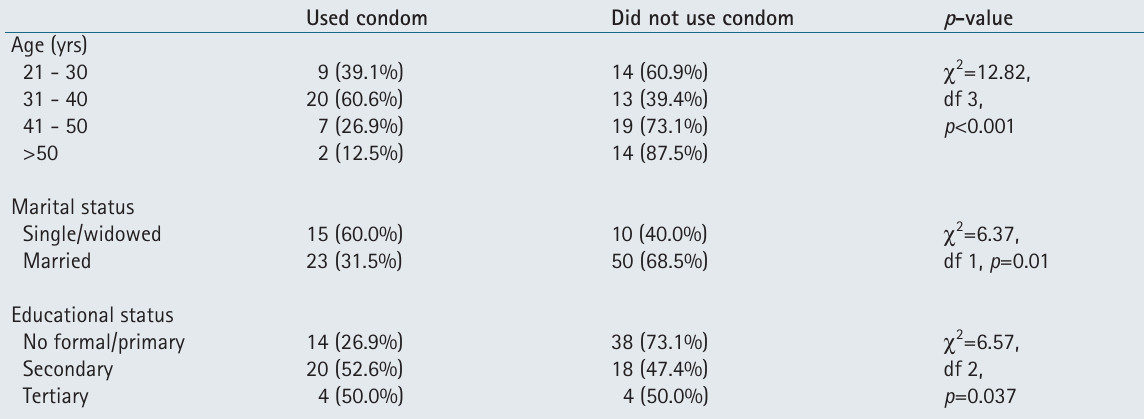
taBle iii. relationSHiP BetWeen Socio-DeMograPHic VariaBleS anD USe oF conDoM in laSt eXtra-Marital SeX (73